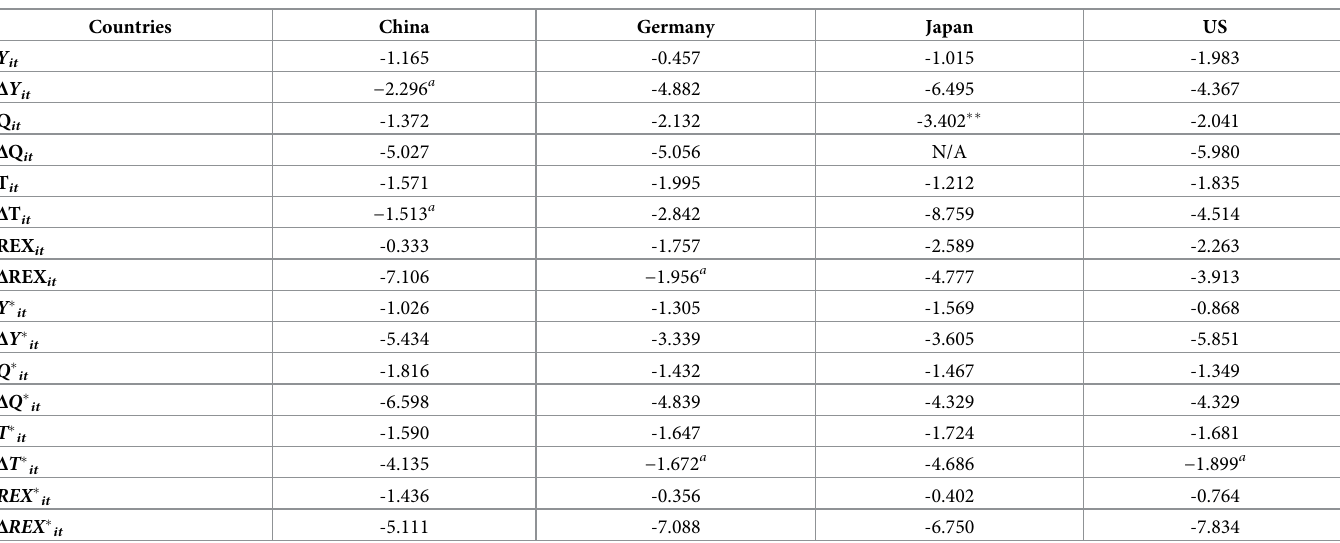
Table 7. Unit root test for domestic variables.